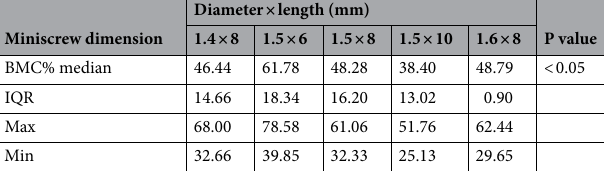
Table 2. BMC% among five different miniscrew